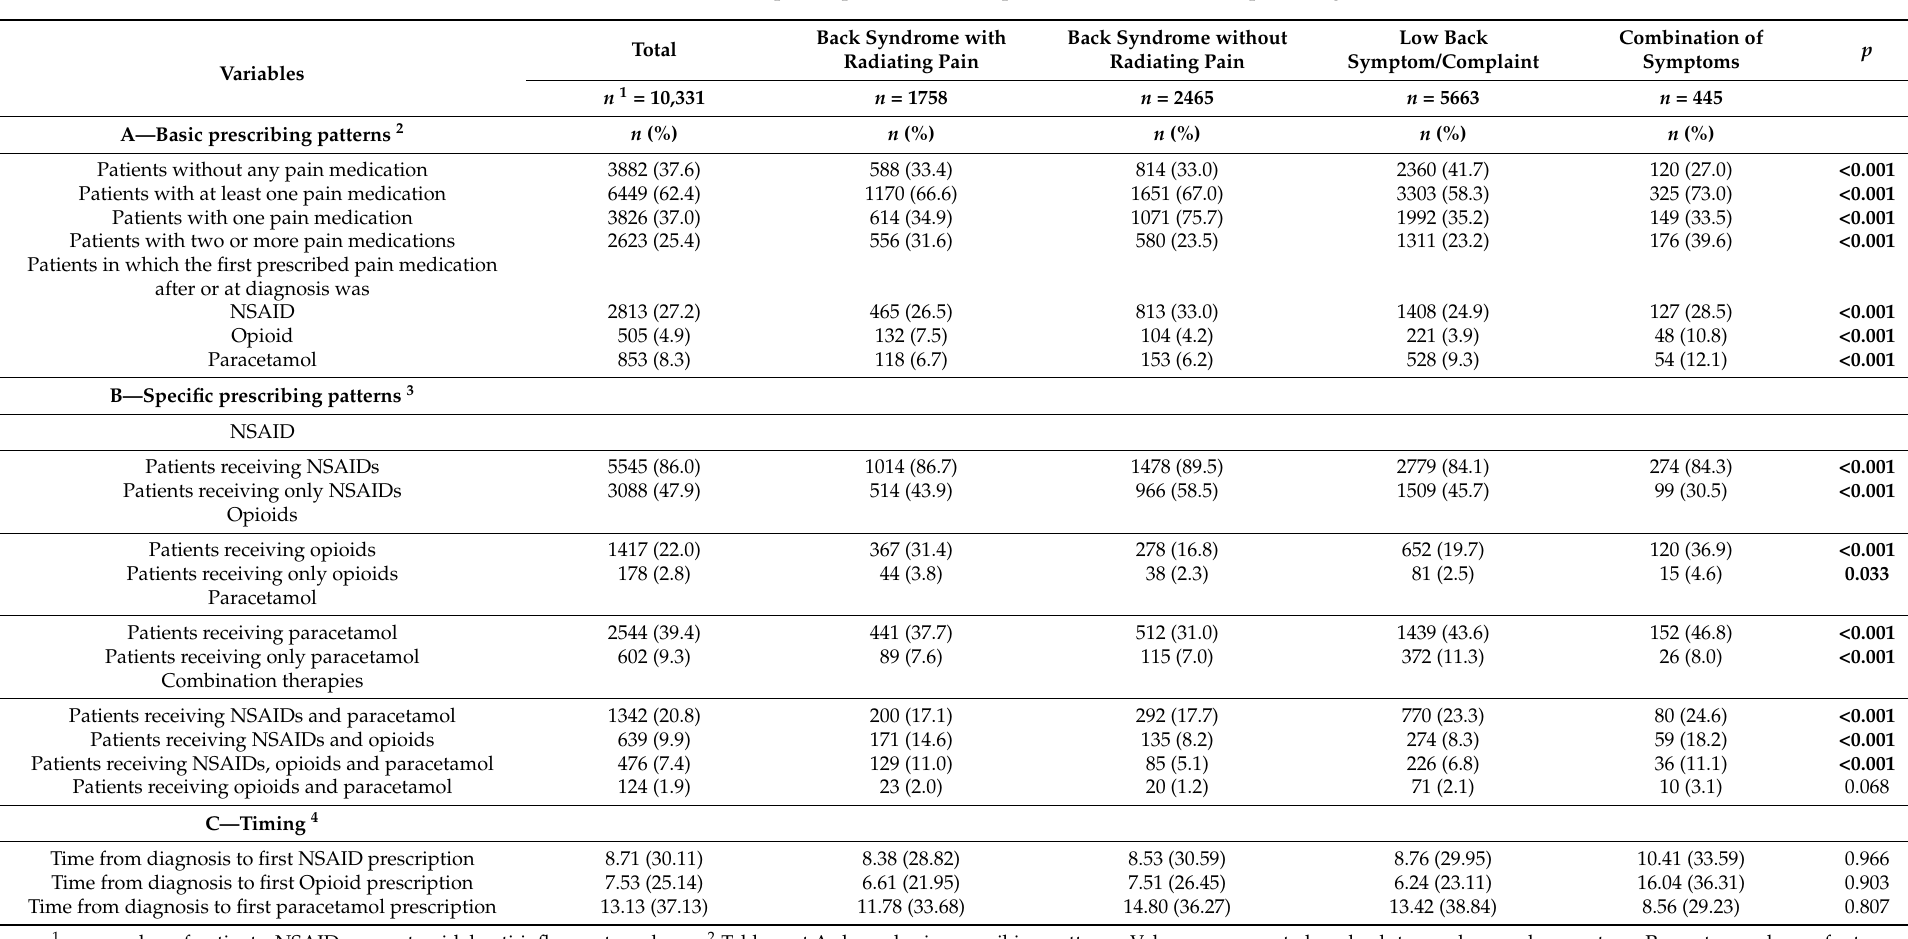
Table 2. Pain medication prescriptions in 10,331 patients with a low back pain